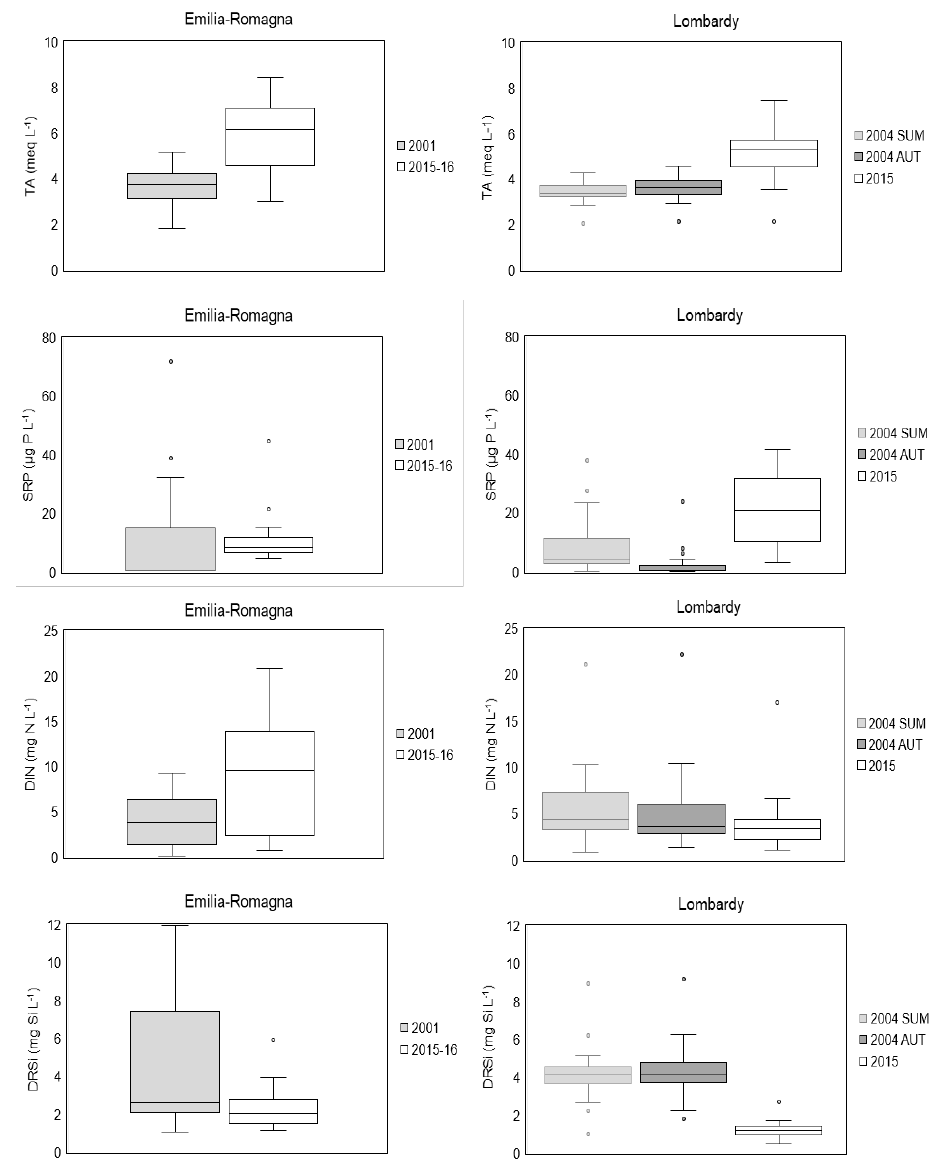
Figure 3. Box-plots showing comparison between TA, SRP, DIN, and DRSi values measured in the present study and in previous research [10,15]. Symbols of box-plots are as in Figure 2.